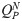
Selection for two GAPs produces a greater increase in modularity in sparser networks.The selection regimes are the same as in Fig 3. In a first stage, selection favoured networks that produced target GAP I. In a second stage, networks with highest fitness were those that produced GAPs I and II in cells with different initial system states (Fig 3A). The QPN score refers to a partition P that assigns the first five genes to one set and the rest of the genes to another. The number of expected interactions is modulated through γ, the relative propensity to acquire interactions.